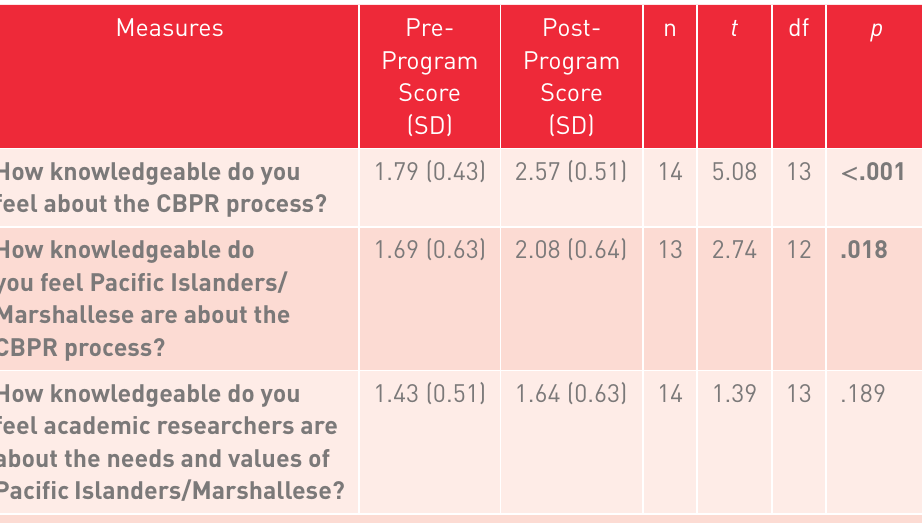
Table 6: Comparison of Pre/Post-Survey